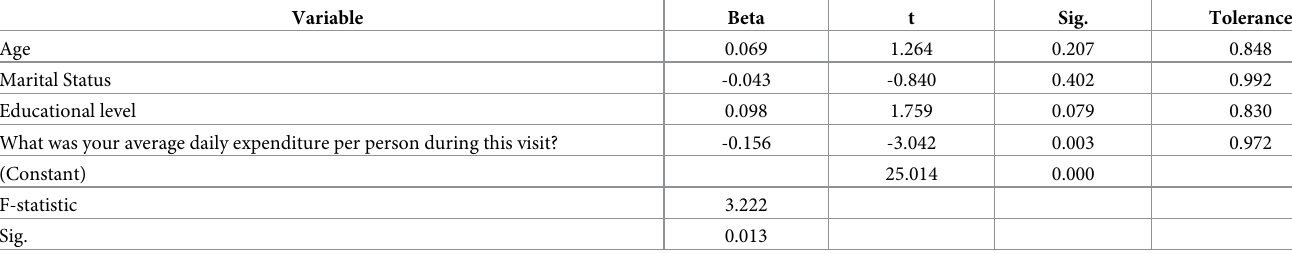
Table 6. Socio-demographic variables and saying positive about